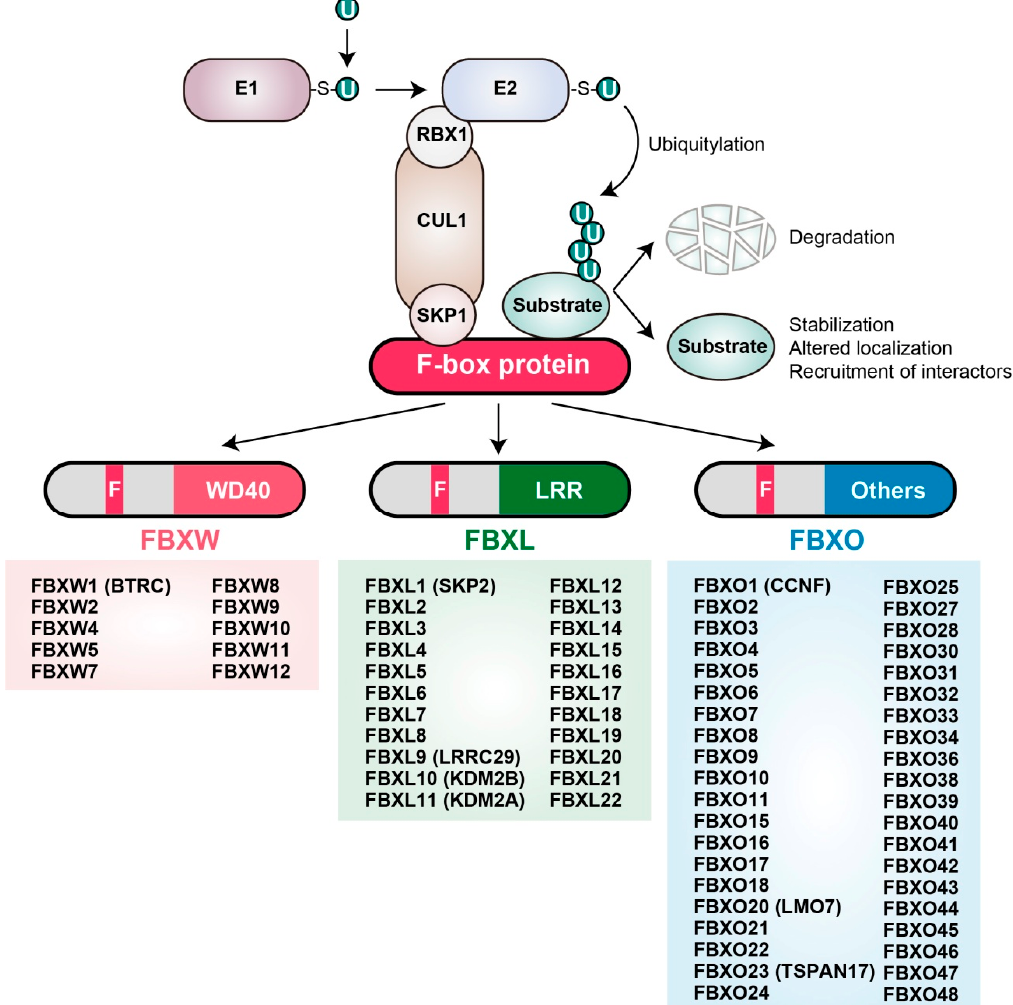
Figure 1. The S-phase kinase-associated protein 1 (SKP1) - Cullin1 (CUL1) - F-box protein (SCF) complex and its ubiquitylation of target proteins. The SCF complex functions together with E1 and E2 enzymes to mediate the ubiquitylation of target proteins. Each F-box protein binds to SKP1 via its F-box domain and to a substrate via its COOH-terminal substrate interaction domain, thereby presenting the target protein for ubiquitylation. The SCF complex-mediated formation of a polyubiquitin chain on a substrate in most instances serves as a signal for proteasome-mediated degradation, although in some cases it instead leads to protein stabilization, a change in localization, or recruitment of other binding proteins (see sections 2.2. and 3.1.). F-box proteins fall into three major classes based on the type of substrate interaction domain: those that contain WD40 repeats (FBXW), leucine-rich repeats (FBXL), or other protein interaction domains (FBXO). Human F-box proteins in each class are shown. U,